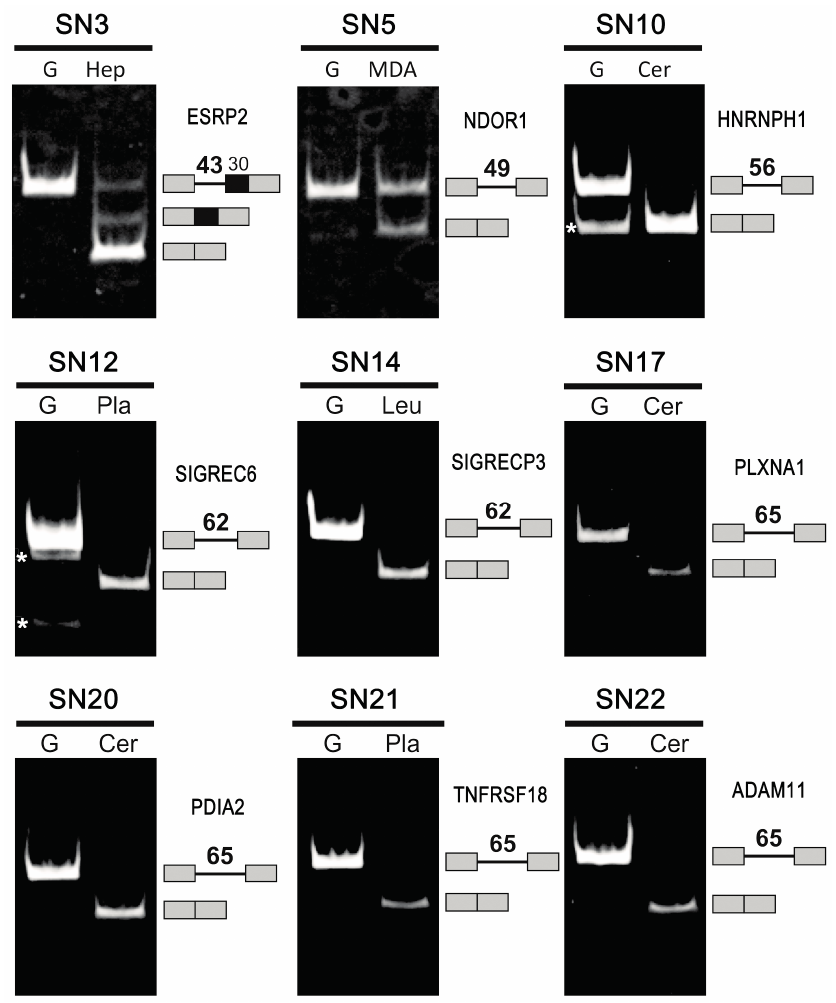
Figure 2. Splicing of 9 human ultra-short introns was detected in the indicated human cells (Hep, HepG2 cells; MDA, MDA-MB231 cells) and tissues (Cer, Cerebrum; Pla, Placenta; Leu, Leukocytes). See Table 1 for the gene names and serial numbers (SN). RT–PCR targeting the indicated endogenous gene transcripts was performed. G indicates the fragments that were amplified from genomic DNA. The amplified fragments corresponding to the pre-mRNAs and spliced mRNAs, separated by 5% PAGE, are indicated on the right with their schematic structures and the lengths of the introns (in nt). Asterisks ( * ) indicate nonspecific by-products that were not relevant to splicing. See Table S3 for more detailed